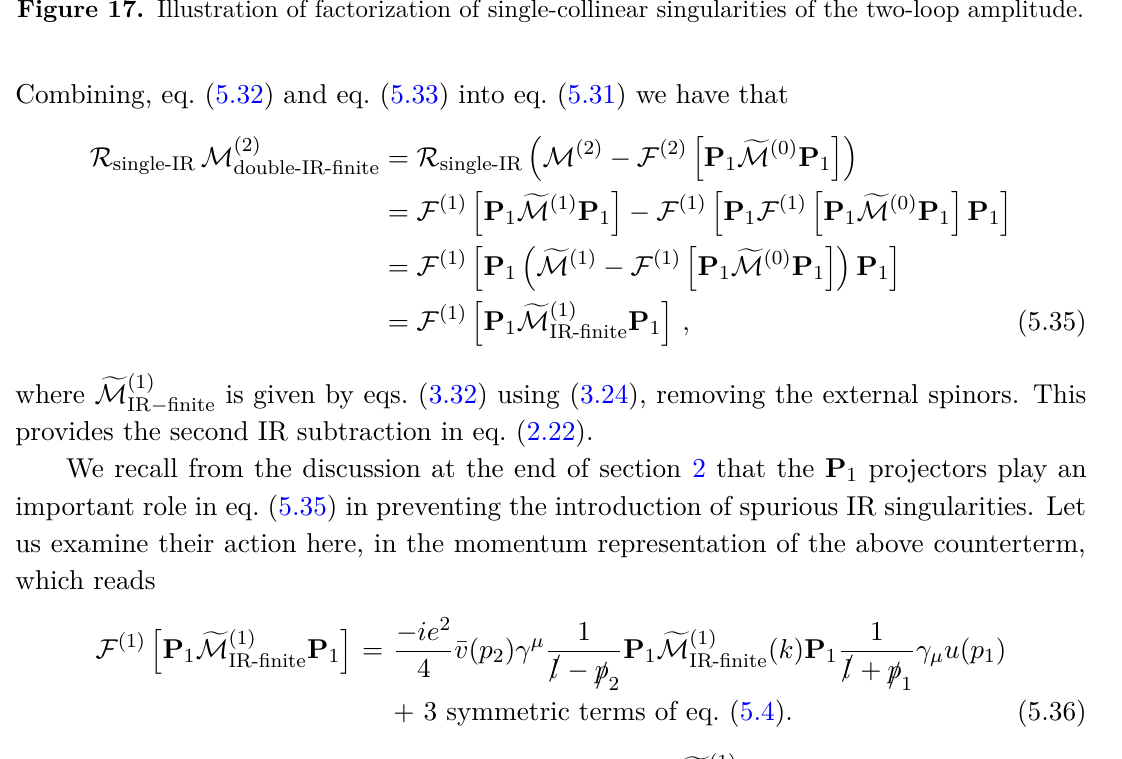
Figure 17. Illustration of factorization of single-collinear singularities of the two-loop